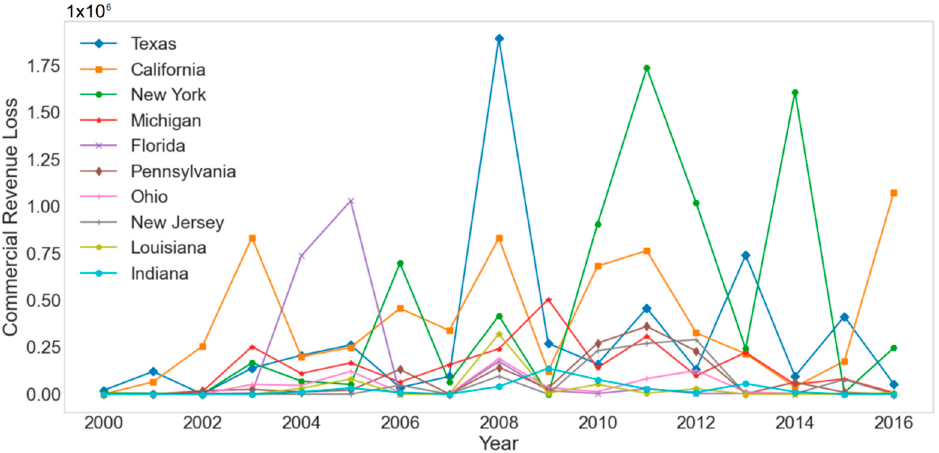
Figure 12. Revenue loss in commercial sector for top 10 individual states during 2000–2016 due to power outages.